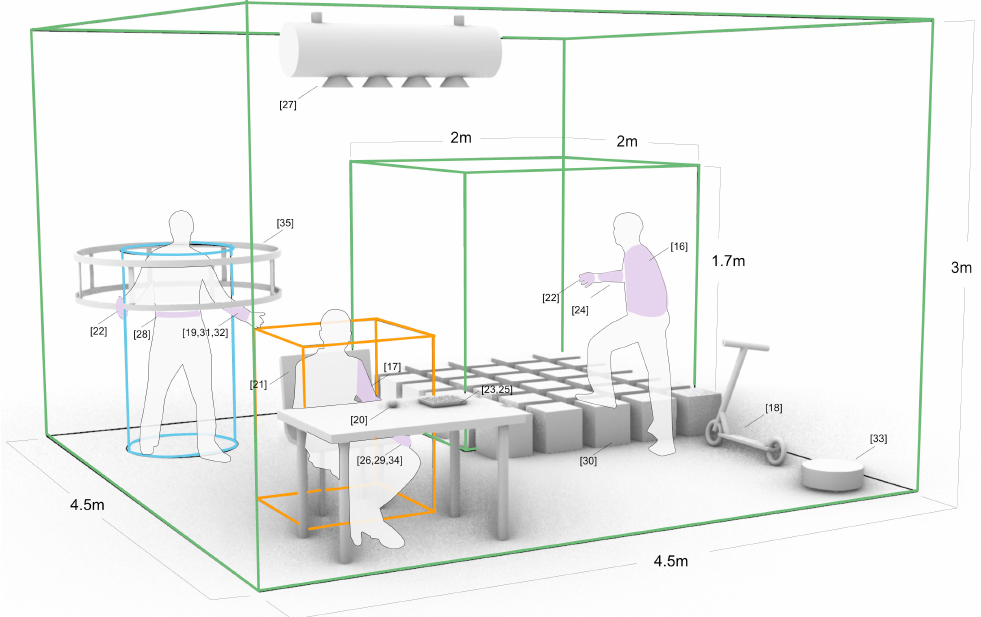
Figure 2. A spatial design space for haptic VR across three RE scales: Seated (in orange), Standing (in blue), and Walking (in green), ranging from 2 × 2 × 1.7 m to 4.5 × 4.5 × 3